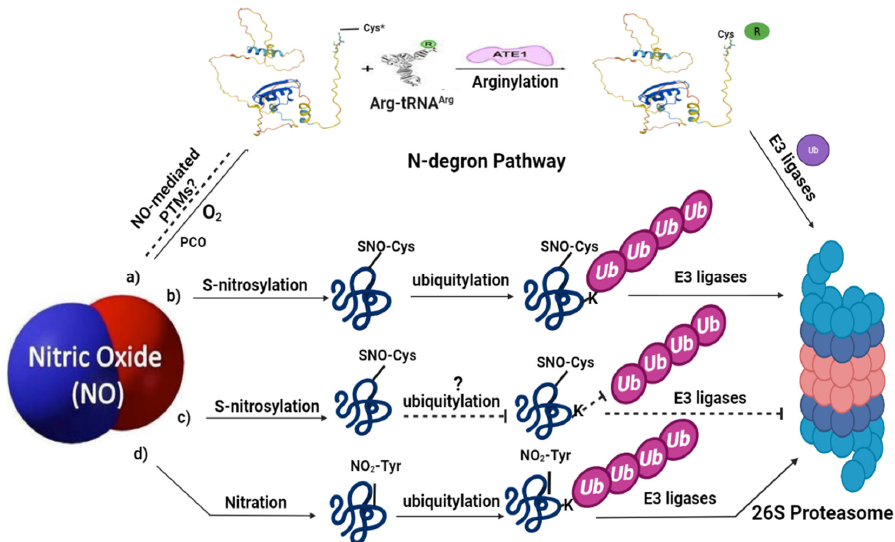
Figure 2. Nitric oxide signaling associated with ubiquitin-mediated proteolysis in plants: ( a ) represents the N-degron pathway (already described in detail in Figure 1); ( b ) under certain environmental conditions, NO can trigger ubiquitin-mediated proteasomal degradation of some proteins via S -nitrosylation, for example, APX1 and ABI5; ( c ) meanwhile, NO can also protect certain proteins by preventing their degradation via S -nitrosylation; ( d ) NO-mediated PTMs, such as tyrosine nitration, also leads to the proteolytic degradation via ubiquitin-mediated PTMs. Limited evidence is available for these pathways in plants; therefore, the dashed lines and question marks are used which represent further clarification of these signaling pathways in plants. SNO represents S -nitrosothiol; NO 2 -Tyr represents tyrosine nitration. The structure of Arg-tRNA Arg and ATE1 is reprinted (adapted) with permission from [2]. The authors apologize for any inconvenience caused and state that the scientific conclusions are unaffected. This correction was approved by the Academic Editor. The original publication has also been updated.